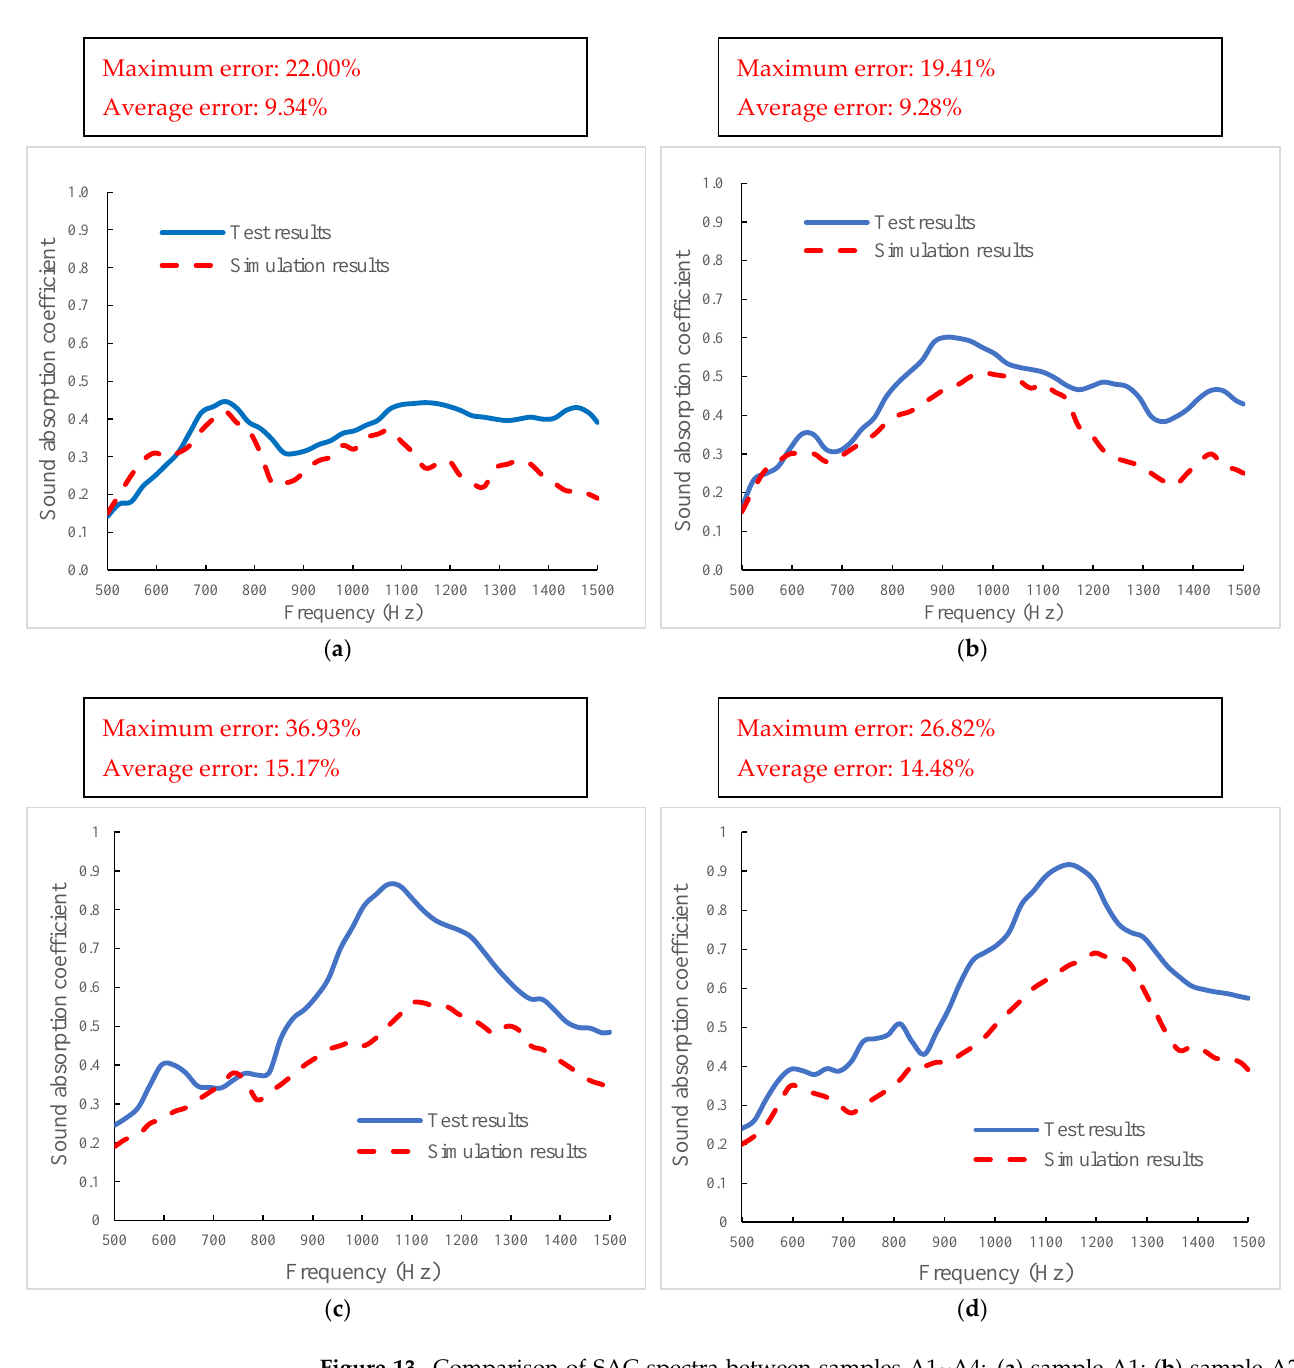
Figure 13. Comparison of SAC spectra between samples A1~A4: ( a ) sample A1; ( b ) sample A2; ( c ) sample A3 and ( d ) sample A4.